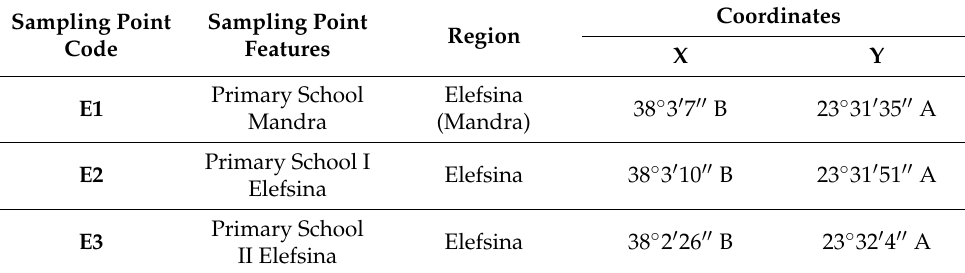
Table 1. Description of Sampling and Coordinating